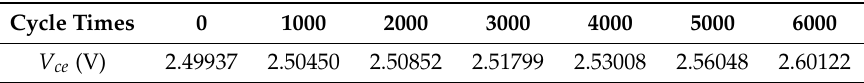
Figure 4. The I - V characteristic curve of IGBT under different aging states. Table 1. The saturation voltage drop V ce of IGBT under different aging states.